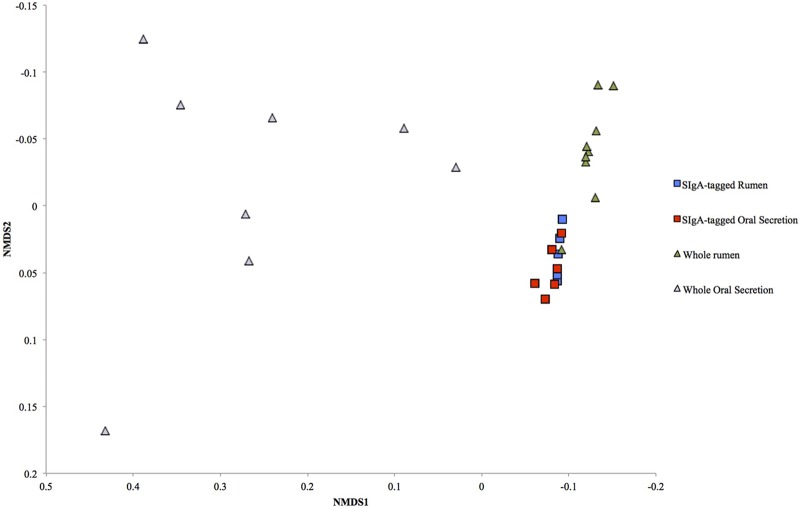
Non-parametric multidimensional scaling (NMDS) ordination plot of bacterial communities. The NMDS plot was generated using Euclidean distance metric between whole rumen, oral secretion, SIgA-tagged rumen, and SIgA-tagged oral secretion microbiota. Each dot represents an individual sample collected from whole rumen (n = 9), oral secretion (n = 10), SIgA-tagged rumen (n = 5), and SIgA tagged oral secretion (n = 6). The R2 for NMDS1 and NMDS2 axes were 0.94 and 023, respectively.